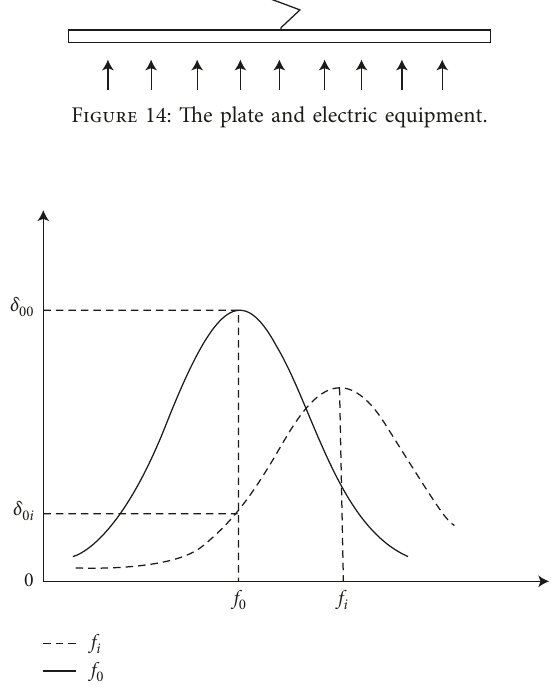
Figure 15: Response at same specific frequency under different loads.